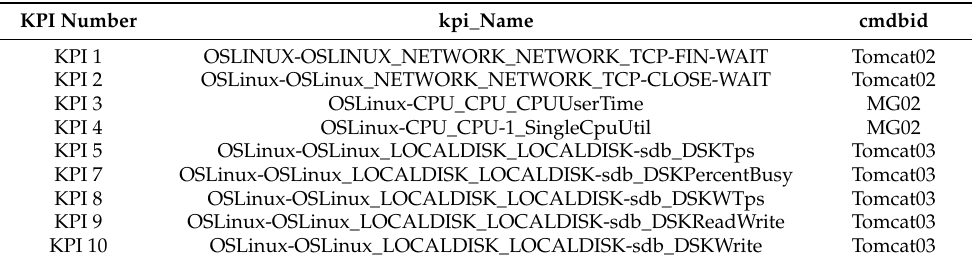
Table 7. KPIs used in the second set of correlation